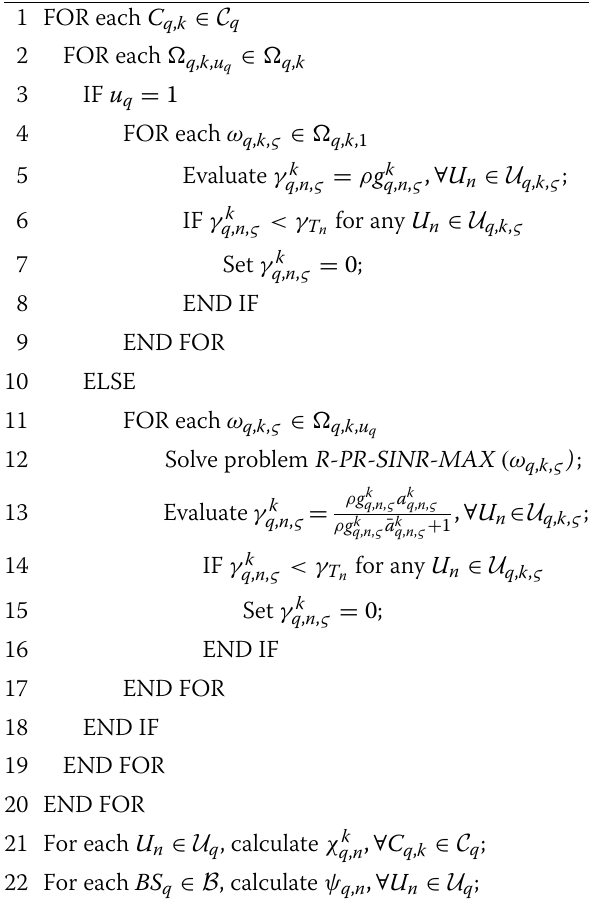
Algorithm 1 Solution Procedure for